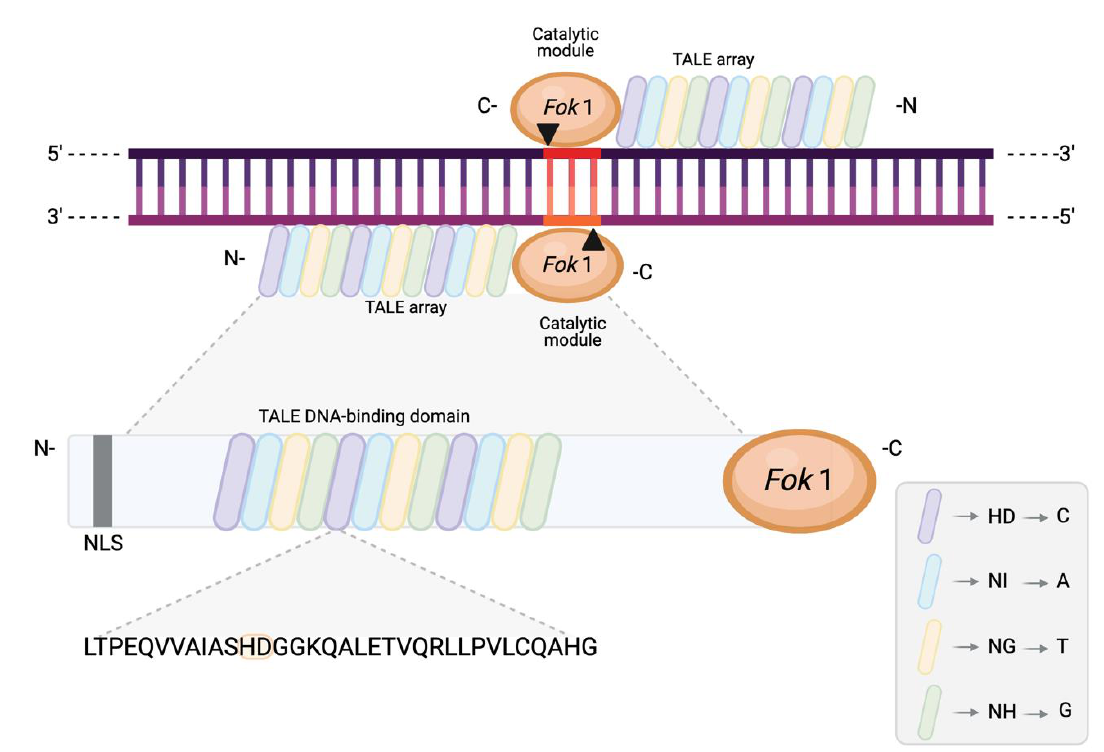
Figure 4. Schematic representation of a TALEN pair with its distinct binding and recognition domain (TALE array) and cleaving domain (FokI). The arrows and the highlighted region represent the resulting DSB and 3-nt 5′ overhangs. Each TALE array contains 15–19 individual tandem repeats, each comprising a conserved sequence of 33–35 amino acids that differ only at amino acid positions 12 and 13. These two amino acid residues are known as the repeat variable diresidue (RVD) and determine the nucleotide binding specificity. The inset presents a small subset of the RVD base “code” for illustrative purposes. NLS, nuclear localisation signal.